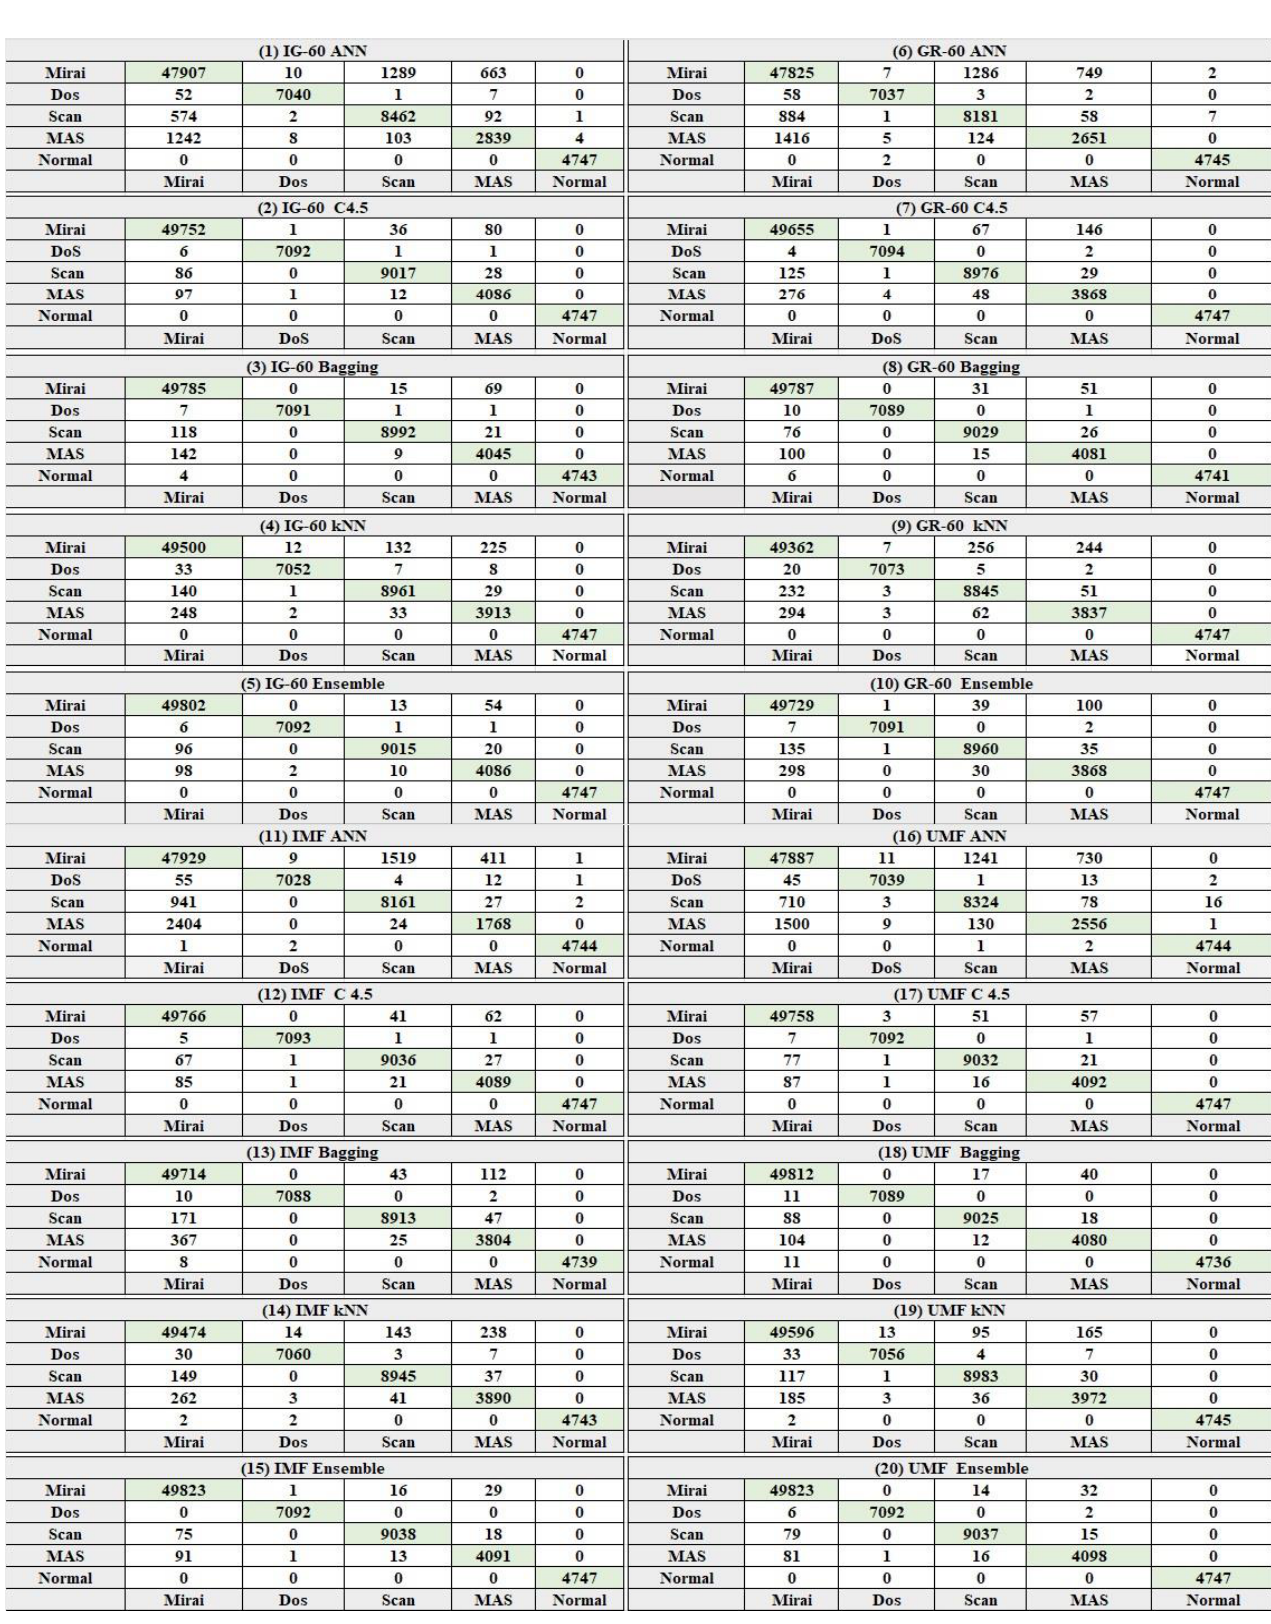
Figure 9. Confusion matrix yielded by the five various ML with different FS approaches for multi- classification of the IoTId20 dataset.